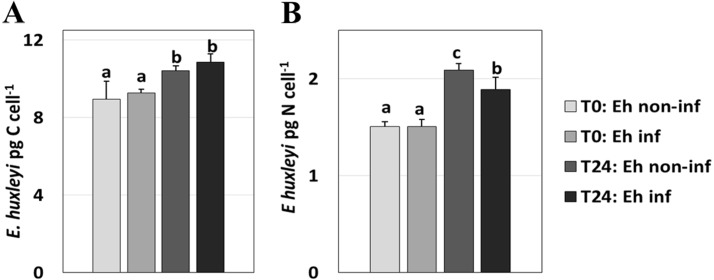
E. huxleyi C and N concentration.E. huxleyi C (A) and N (B) concentration (pg cell −1) at 0 and 24 hours p.i. Values are mean ± one standard deviation. Letters indicate statistical similarity. Same letters indicate no statistical difference between compared treatments and different letters denote significant statistical differences.